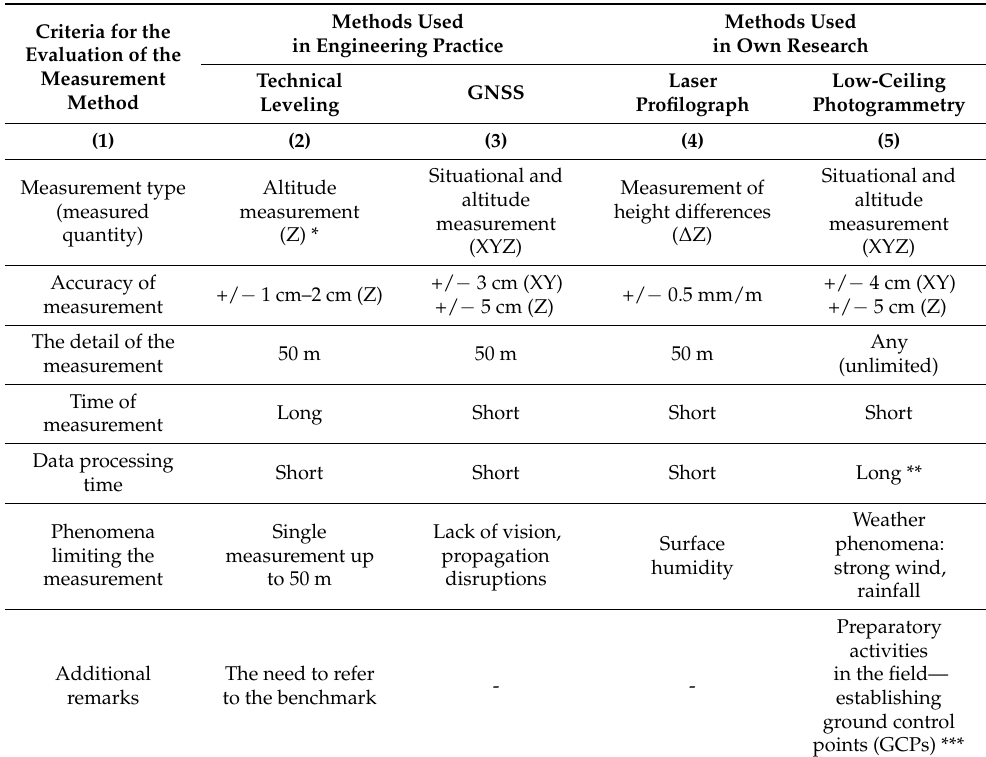
Table 3. List of selected properties of the measurement methods used. Criteria for the Evaluation of the Measurement